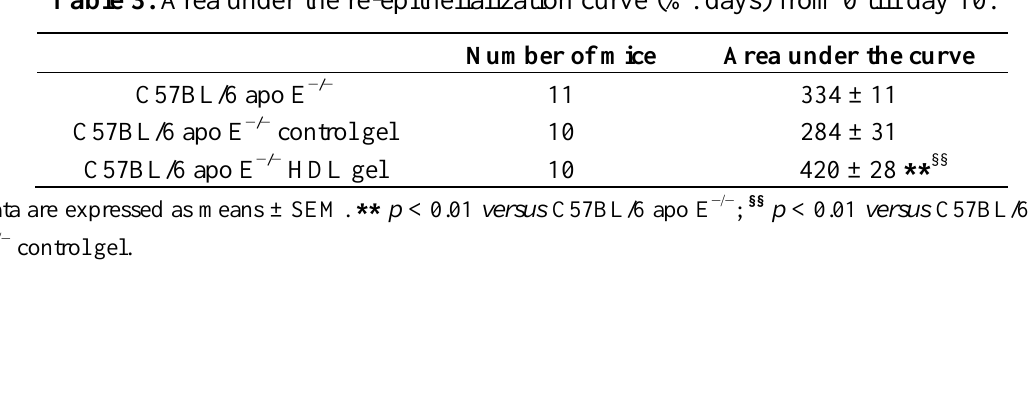
Table 3. Area under the re-epithelialization curve (%. days) from 0 till day